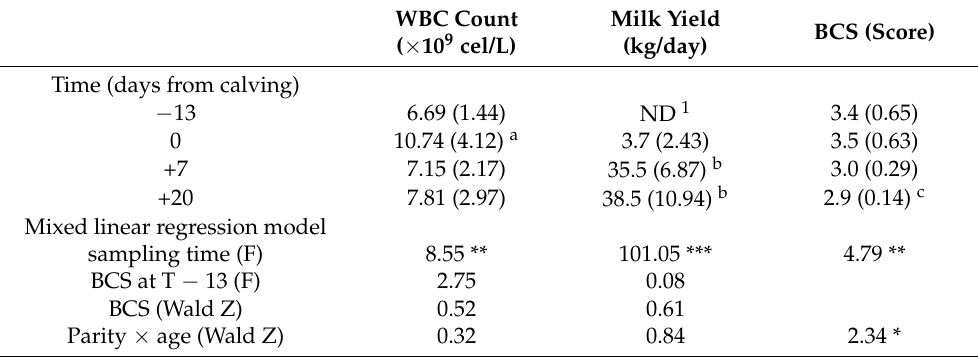
Table 1. White blood cell (WBC) count, milk yield and body condition score (BCS) changes during the transition period. Values were expressed as mean (standard